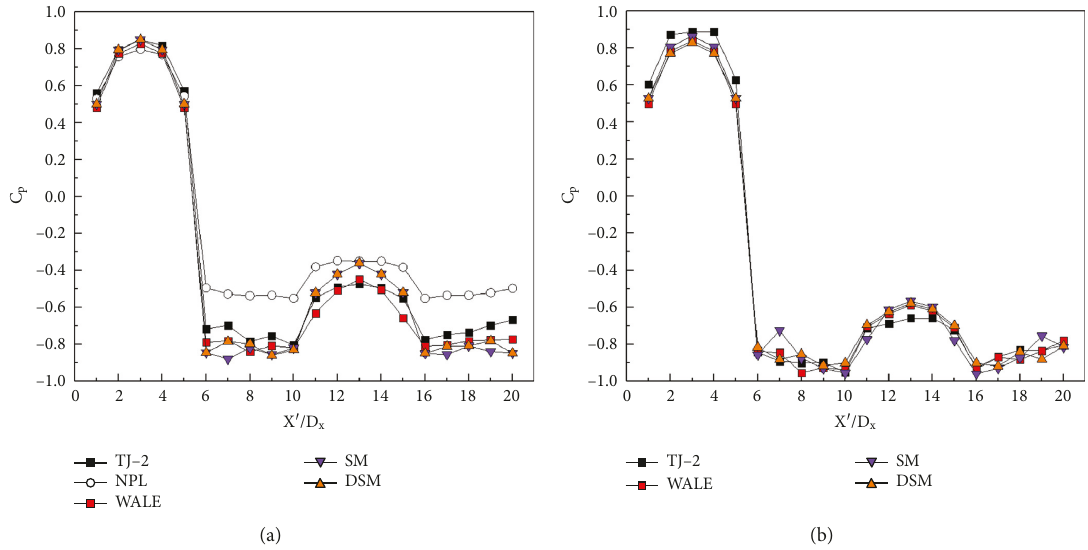
Figure 4: Average wind pressure coefficient at 0 ° wind direction angle. (a) Class D wind farm. (b) Class B wind farm.